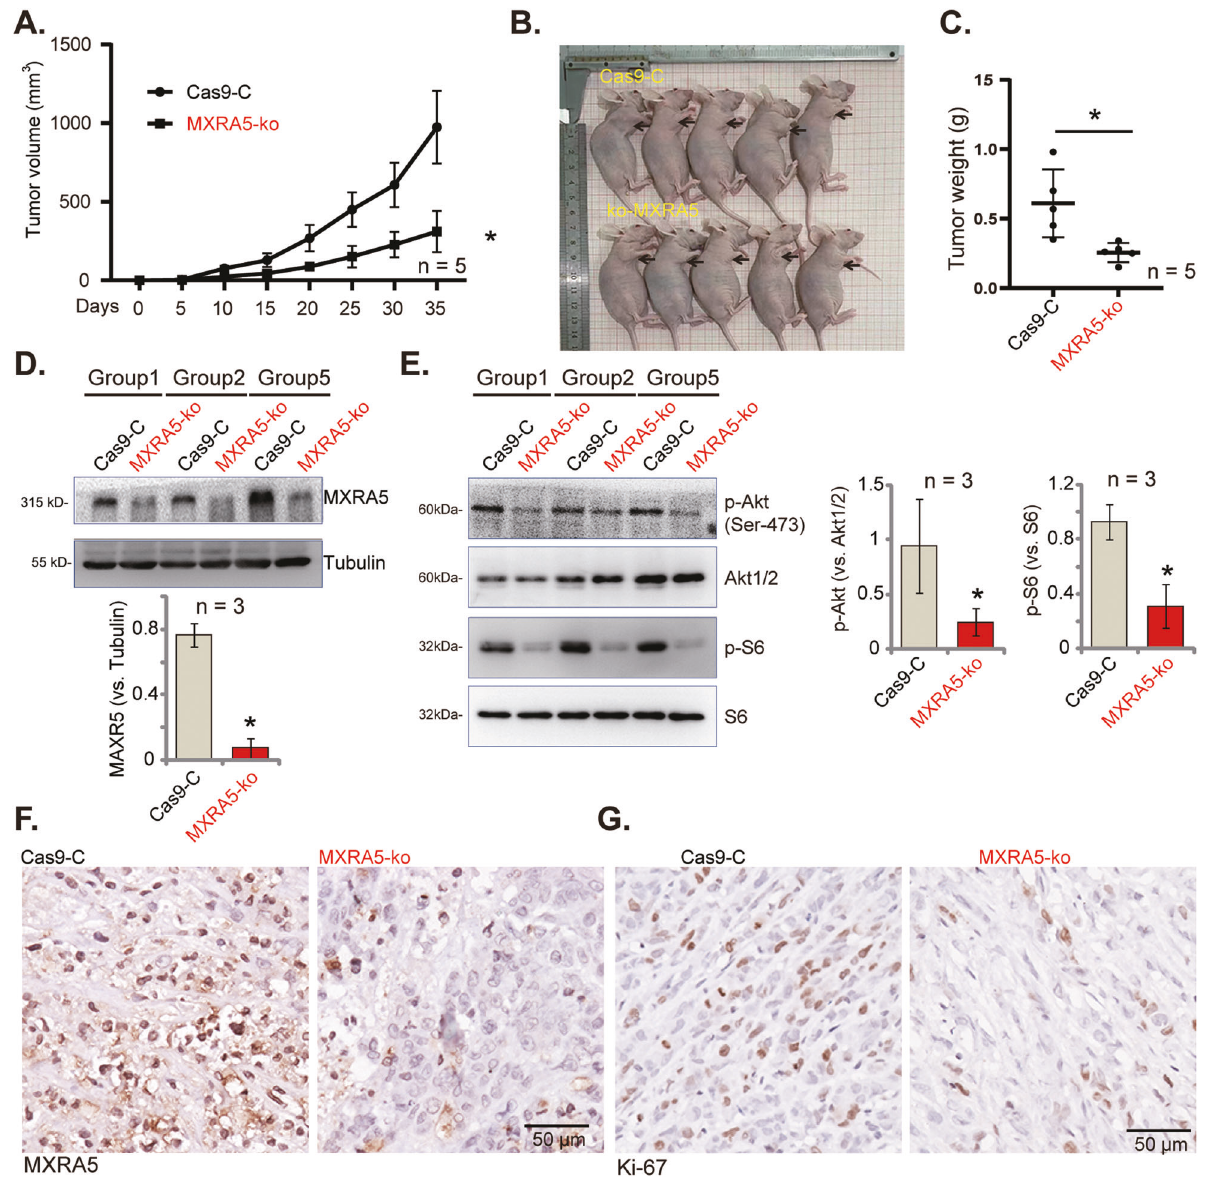
Fig. 7 MXRA5 KO suppresses PANC-1 xenograft growth in vivo. PANC-1 xenografts were established by subcutaneous injection of PANC-1 cells (6 × 10 6 cells per mouse), expressing the sgRNA-CRISPR/dCas-9 MXRA5-KO lentiviral construct ( “ MXRA5-ko ” ) or Cas9 control construct ( “ Cas9-C ” ), to the nude mice, and tumor volumes were recorded every fi ve days ( A ). After 35 days, PANC-1 xenografts were measured ( B ) and weighted ( C ). The tumor tissue lysates were obtained, and expression of listed proteins was tested by Western blotting assays ( D and E ), with results quanti fi ed. The representative IHC images showed MXRA5 ( F ) and Ki-67 ( G ) expression in the xenograft tissue slides. Data were presented as mean ± standard deviation (SD). * P < 0.05 vs. “ Cas9-C ” tumors. Scale bar = 50 μ m.